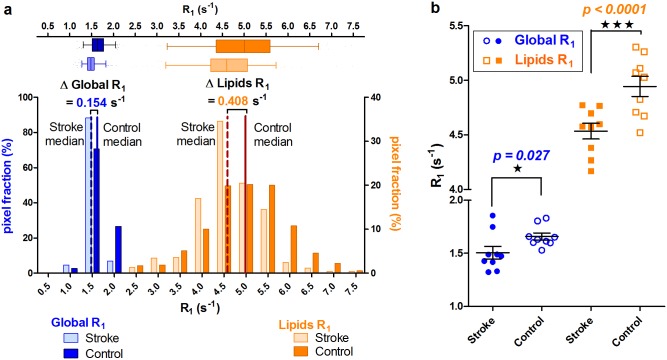
Comparison between infarcted and mirrored normoxic areas in patients.Histogram and scatter-plot of pooled 9 infarcted areas (‘stroke’) versus unaffected mirror areas (‘control’). 3.a: Histograms demonstrated that the shift to lower values of lipids R1 in stroke areas (0.408 s-1; p<0.0001) is more pronounced than the corresponding shift observed with global R1 values (0.154 s-1; p<0.027). 3.b: Scatter plots demonstrated a greater difference between medians for lipids R1 at 0.409 s-1 with p <0.0001 (in orange) than for global R1 at 0.151 s-1 with p<0.027 (in blue).